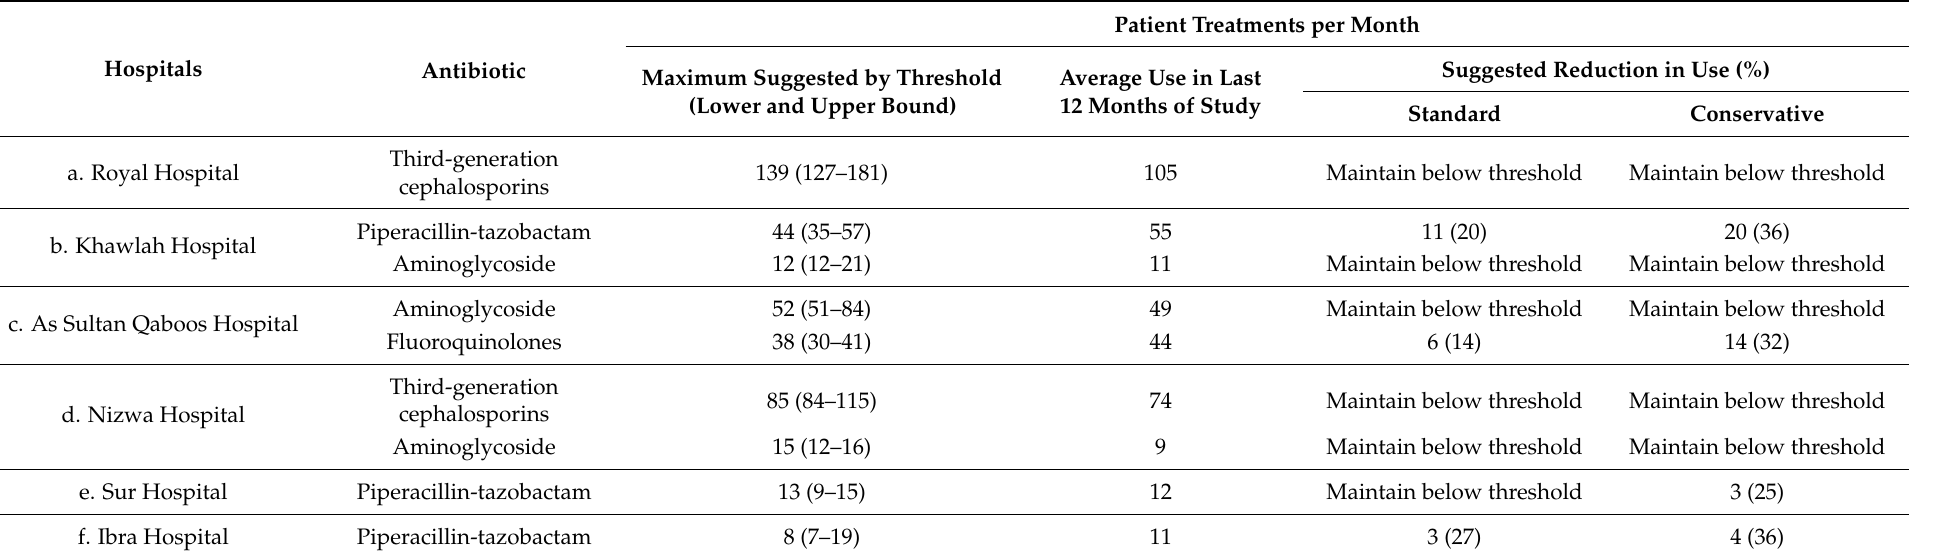
Table 2. Translation of thresholds identified in non-linear models into population-specific antimicrobial stewardship policy